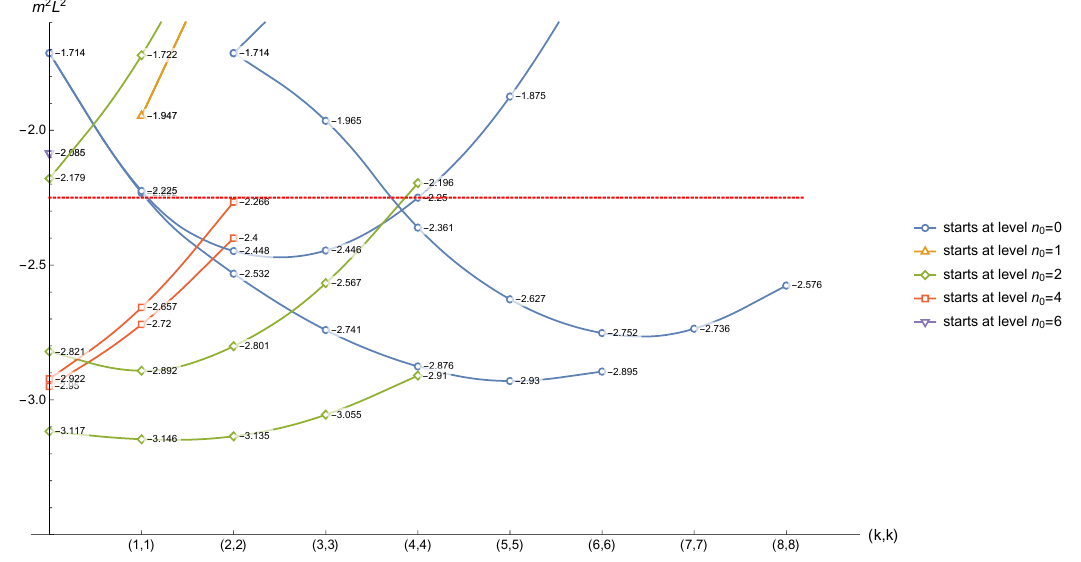
Figure 3 . Lowest Kaluza-Klein modes in the representations ( k ; k ) of SO(3) (cid:2) SO(3) arranged into Kaluza-Klein towers, such that the n th dot on a line starting at level n 0 with k = k 0 sits at level n 0 + n with k = k 0 + n . The colour code indicates the starting level n 0 for the various towers. The dashed red line corresponds to the BF bound.